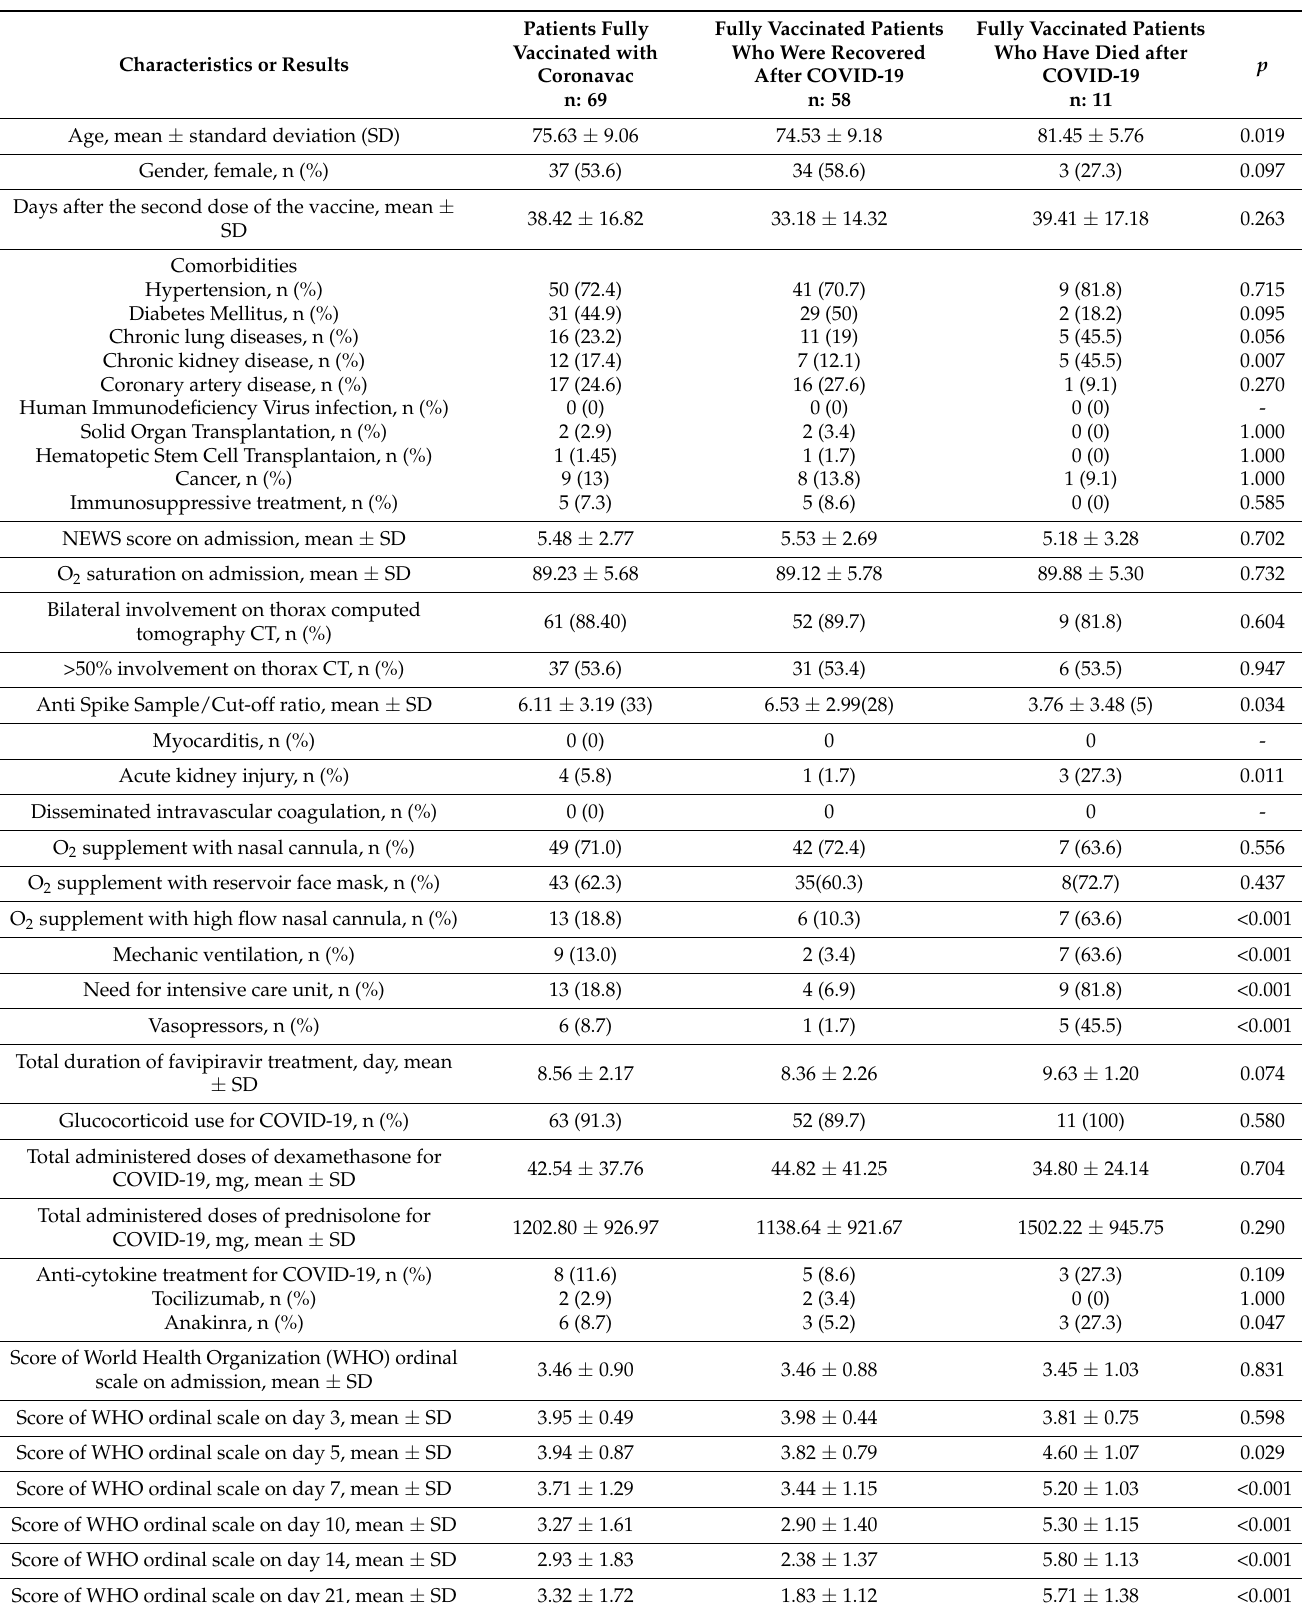
Table 3. Comparison of the patients who recovered or died after vaccine breakthrough